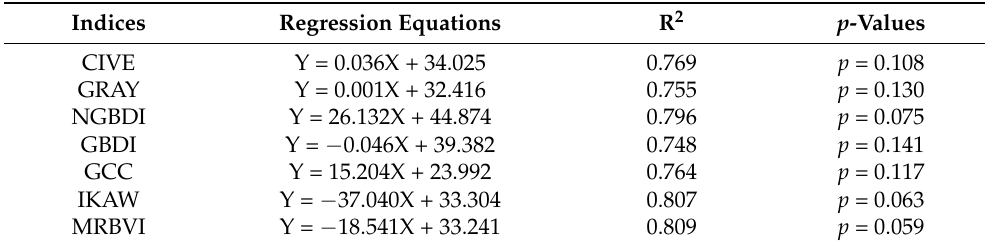
Table 3. The linear regression analysis of RGB-based VIs and maize grain yields during the entire growth stages.